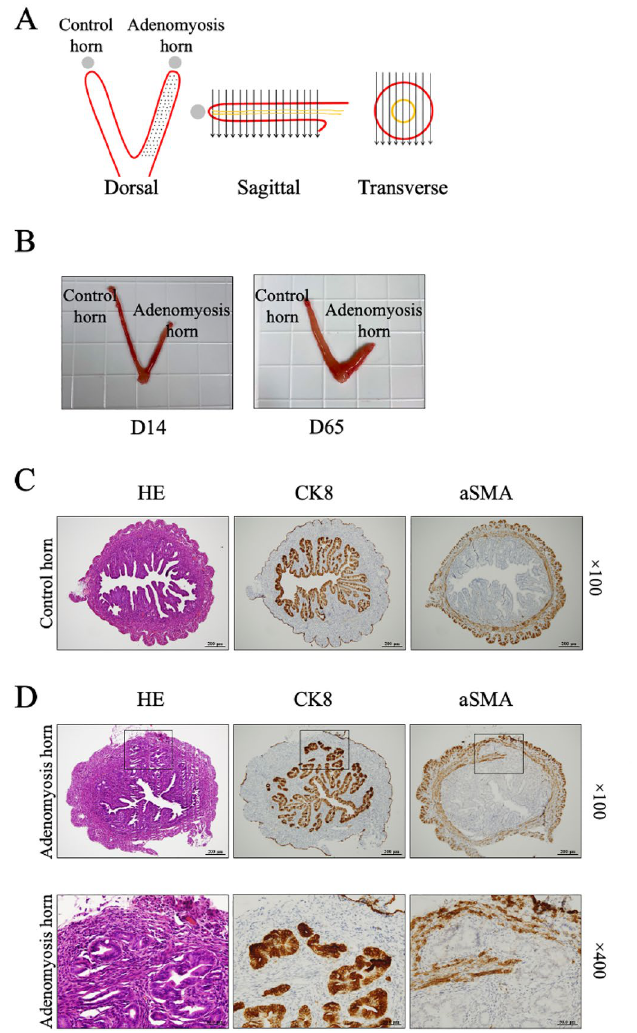
Figure 1. (A) A schema showing the punctures of the uterine horn. The entire uterine wall of one horn was mechanically punctured at a frequency of 100 times/1 cm. The puncture was crossed the whole uterine wall thickness. ( B) A macroscopic finding of the uterus (D14 and D65). At D14, the adenomyosis horn was slightly shorter than the control horn, and the difference became more pronounced in D65. ( C ) A representative microscopic image of the control horn (D65, × 100). Hematoxylin and eosin staining (HE) shows the normal uterine architecture; cytokeratin 8 (CK8) shows eutopic endometrium and alpha smooth muscle actin (α SMA) shows smooth muscle architecture. ( D ) A representative microscopic image of the adenomyosis horn (D65, upper figures; ×100) (lower figures; ×400). Hematoxylin and eosin staining (HE) shows the uterine structure with an adenomyosis lesion (black box); cytokeratin 8 (CK8) shows eutopic endometrial epithelium and epithelium of the lesion (marked with black box), alpha smooth muscle actin (α SMA) shows smooth muscle structure that encircles adenomyosis lesion (marked with black box).